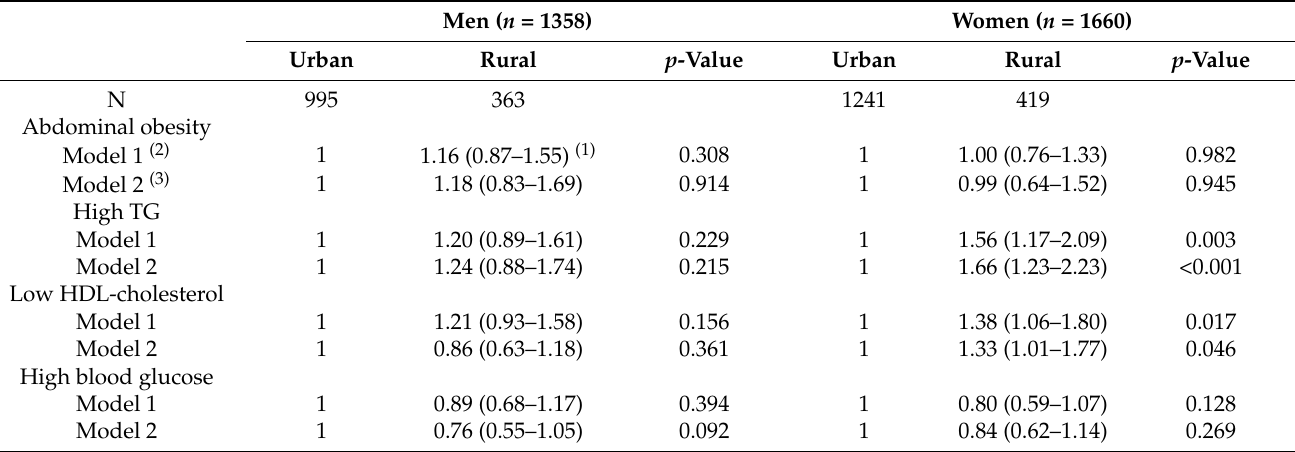
Table 4. OR of metabolic abnormalities of rural and urban elderly. Men ( n = 1358) Women ( n = 1660)